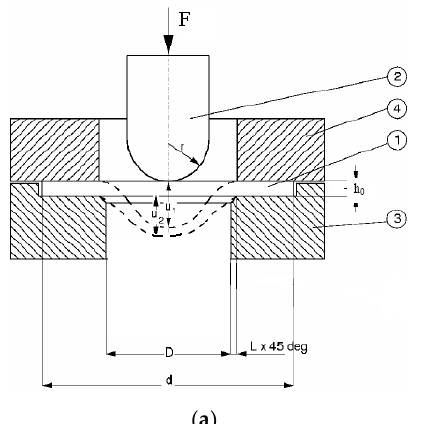
Figure 2. ( a ) The sectional scheme of punch test setup: 1 — specimen; 2 — hemispherical punch; 3, 4 are the lower and the upper parts of the support matrix, respectively; ( b ) Photos of punch positions at the start and end of the punching test process at Instron VHS 40/50-20 servo-hydraulic bench.